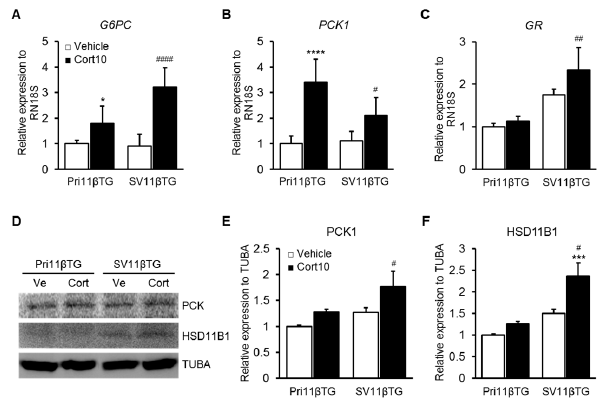
Figure 3. Induction of gluconeogenic markers by cortisone treatment. ( A , B ). The mRNA levels of gluconeogenesis-related genes such as G6PC ( A ) and PCK1 ( B ) were significantly increased in cortisone-treated group of both Pri11 β TG and SV11 β TG hepatocytes; ( C ) The mRNA level of GR binding to cortisol was more increased in SV11 β TG hepatocytes than Pri11 β TG ones. Relative level of these mRNAs was normalized to RN18S ; ( D ) protein level of PCK1 and HSD11B1 was examined by Western blotting method; ( E , F ) Relative expression of these protein was quantified by ImageJ program and normalized to α -tubulin. Both PCK1 and HSD11B1 proteins levels meaningfully increased in cortisone-treated condition of SV11 β TG hepatocytes. Asterisks and number signs respectively mean significant increase comparing to vehicle-treated group of Pri11 β TG (* p < 0.05, *** p < 0.001 and **** p < 0.0001) and SV11 β TG ( # p < 0.05, ## p < 0.01 and #### p < 0.0001) hepatocytes. All experiments were performed independently at least three times. White bars represent vehicle and black bars represent cortisone-treated group. (Ve, vehicle; Cort, cortisone)